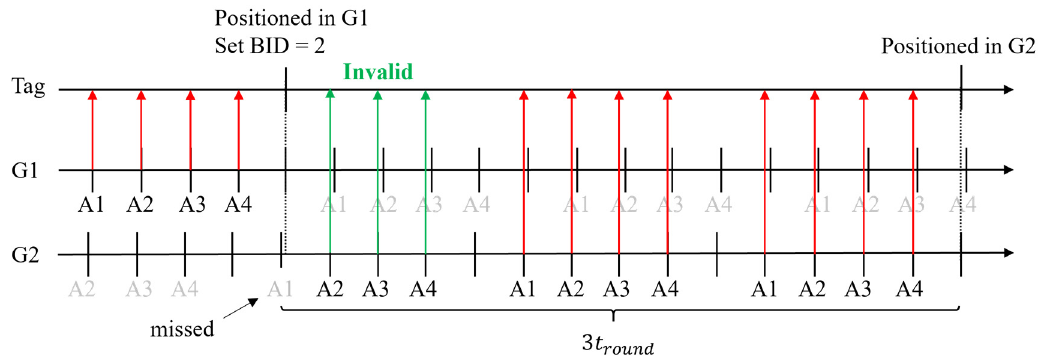
Figure 19. The worst case for the switching group.